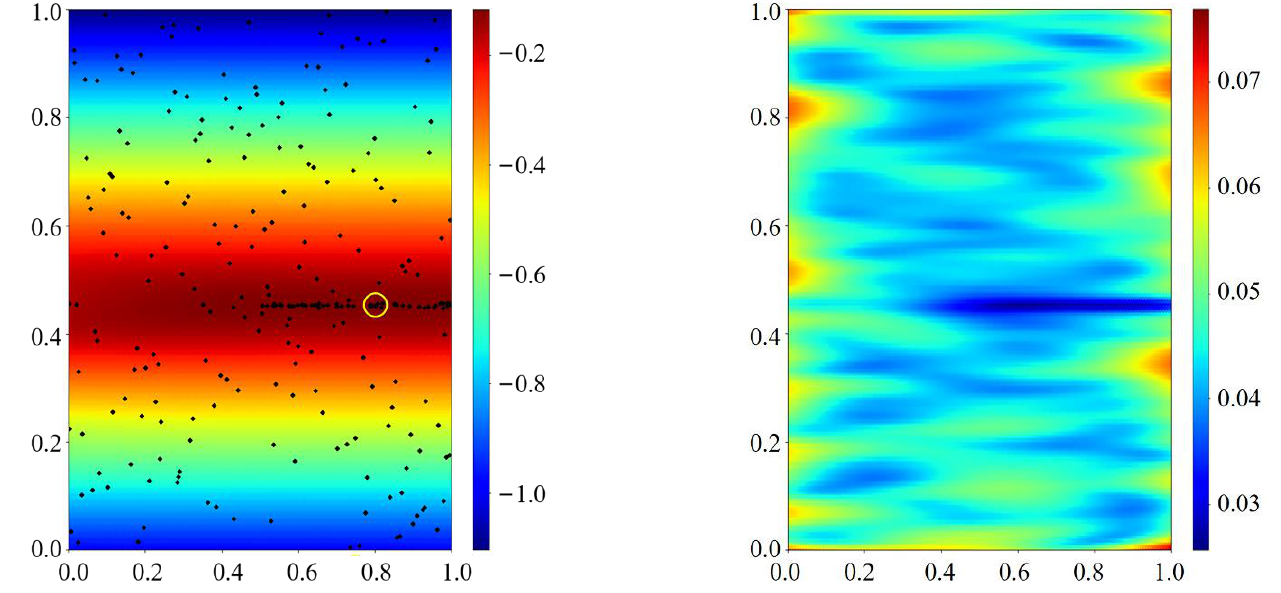
Figure A12. Two-parameter optimization process of a and b in the Toorman model.